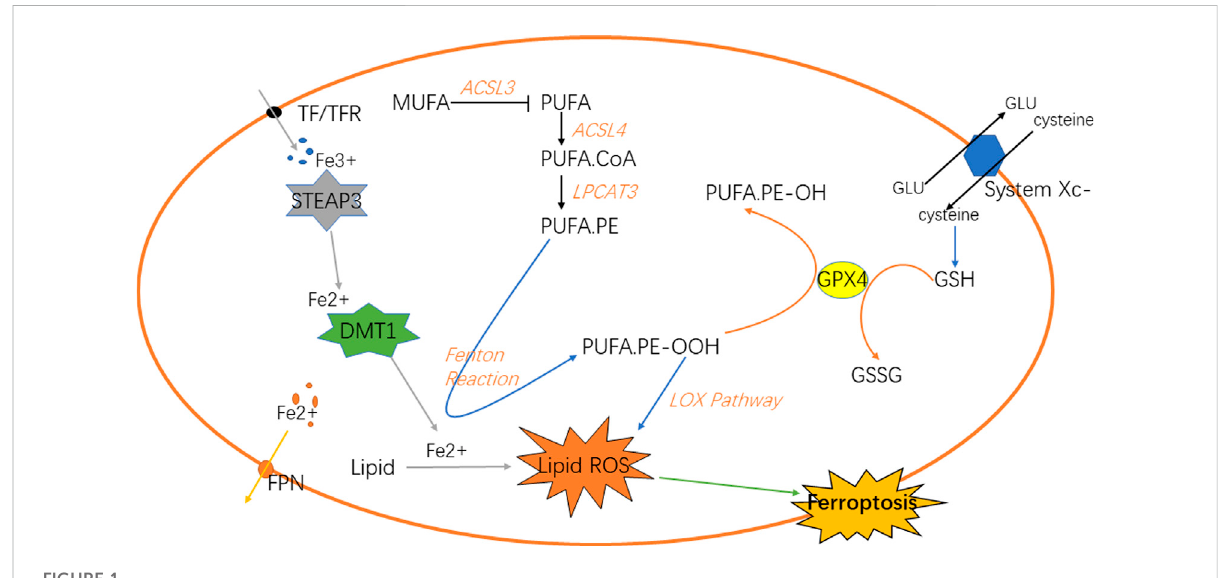
FIGURE 1 Classic signaling pathways of ferroptosis in